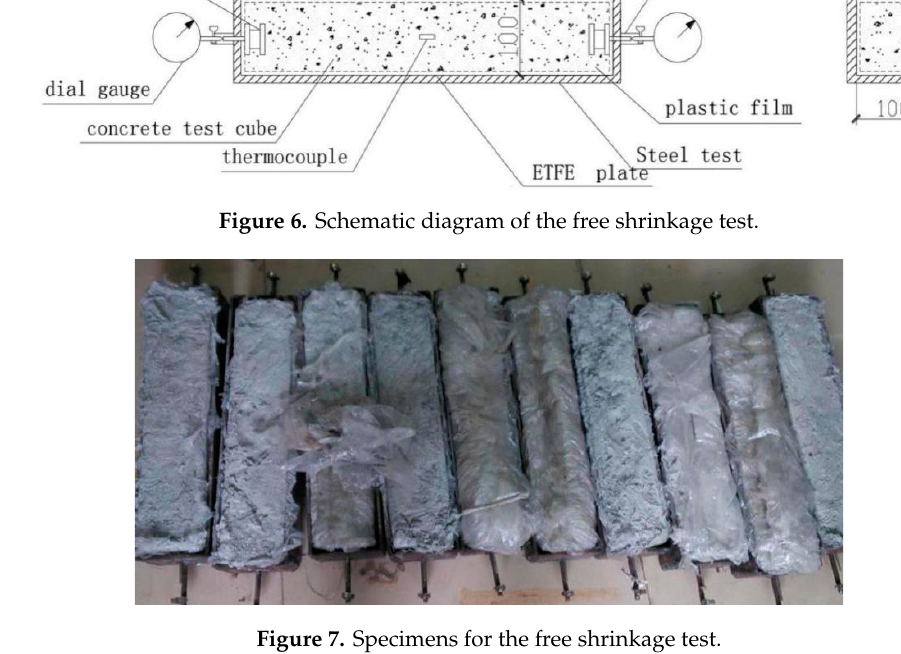
Figure 7. Specimens for the free shrinkage test.